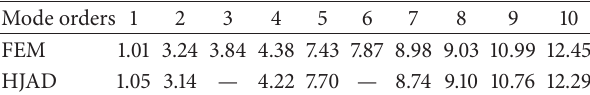
Table 3: The identified natural frequencies of dam. Mode orders